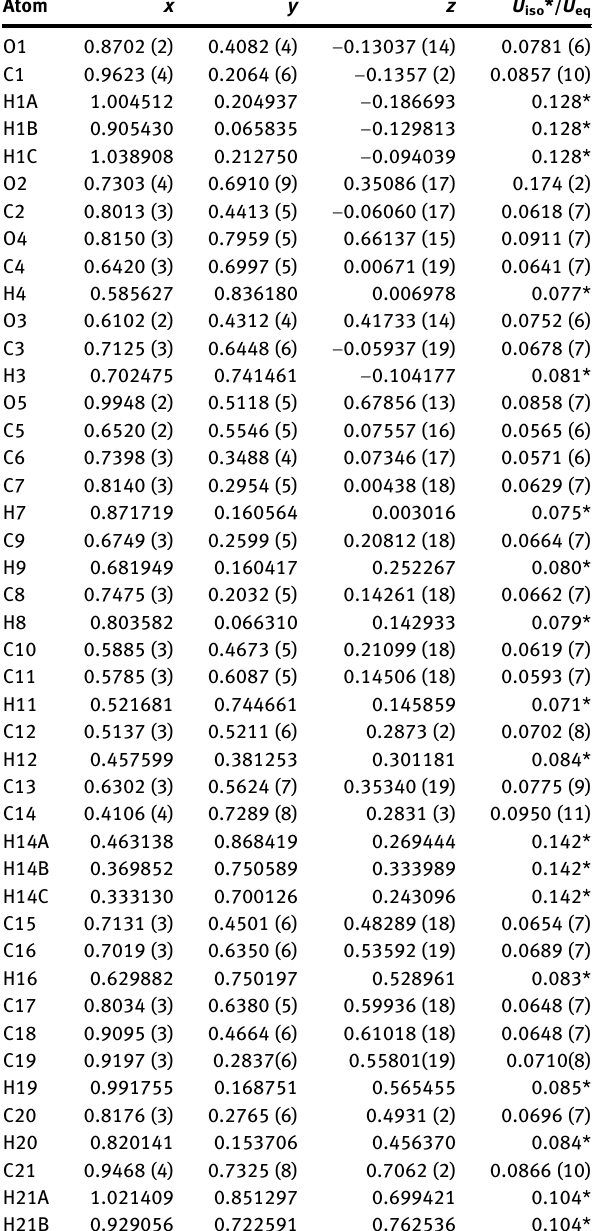
Table  : Fractional atomic coordinates and isotropic or equivalent isotropic displacement parameters (Å 